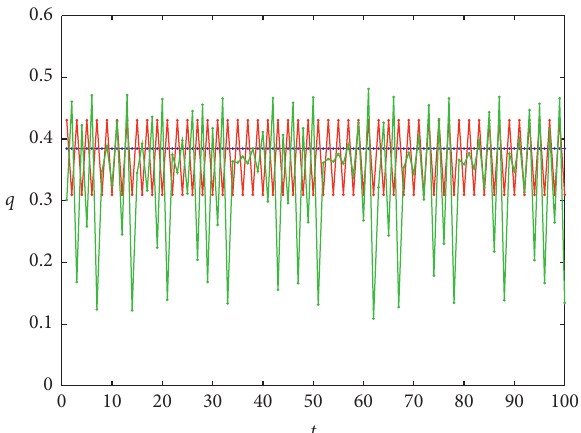
Figure 5: When α